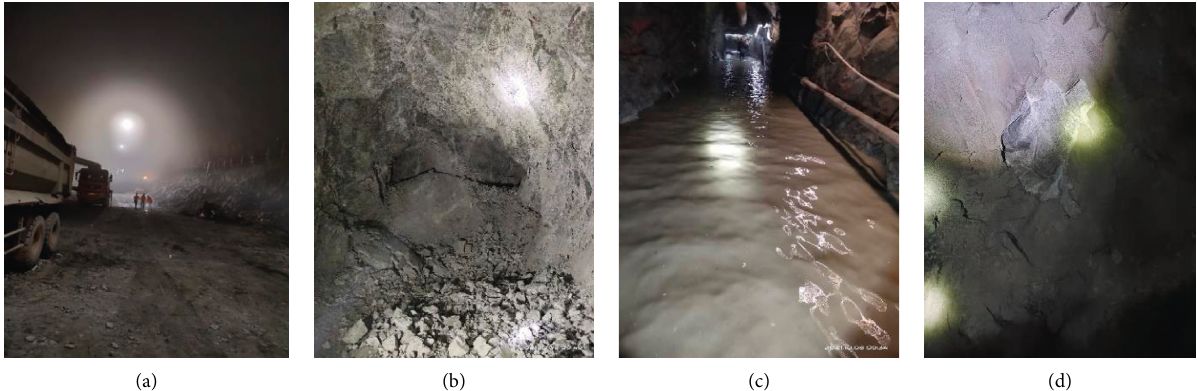
Figure 1: Characteristics of underground cavern. (a) Large span. (b) High stress slab. (c) Abundant groundwater. (d) Rock burst.